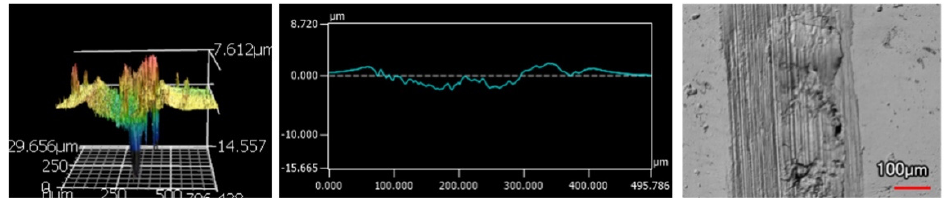
Figure 19. 4 μ m Thick Ni-P-NiTi Coating 100 Passes of the Spherical Indenter.